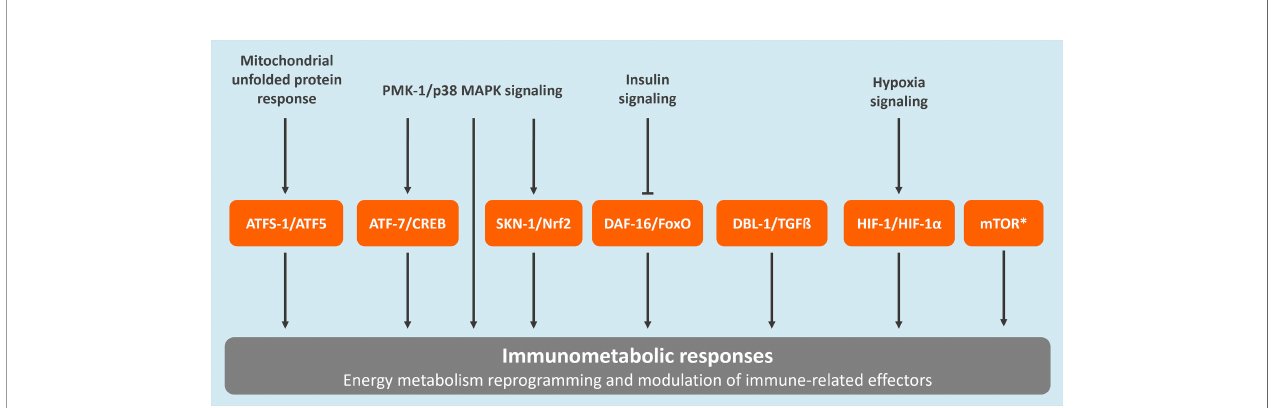
FIGURE 1 | Conserved regulatory pathways associated to immunometabolism in C. elegans . These include the mitochondrial unfolded protein response (UPRmt), the p38 mitogen-activated protein kinase (MAPK) signaling pathway, the insulin/insulin-like growth factor signaling (IIS) pathway, the forkhead box transcription factor O (FoxO)-mediated signaling, the transforming growth factor-beta (TGF b ) signaling pathway, the nuclear factor erythroid 2-related factor 2 (Nrf2) pathway, the hypoxia-Inducible factor (HIF)-1 regulatory pathway, and the mammalian target of rapamycin (mTOR) pathway. The C. elegans protein names are provided followed by the corresponding human homolog. *The mTOR pathway is regulated by two complexes, TORC1 and TORC2. The main proteins composing these complexes, which are conserved between C. elegans and humans, are the following: LET-363/TOR, DAF-15/Raptor, and RICT-1/Rictor